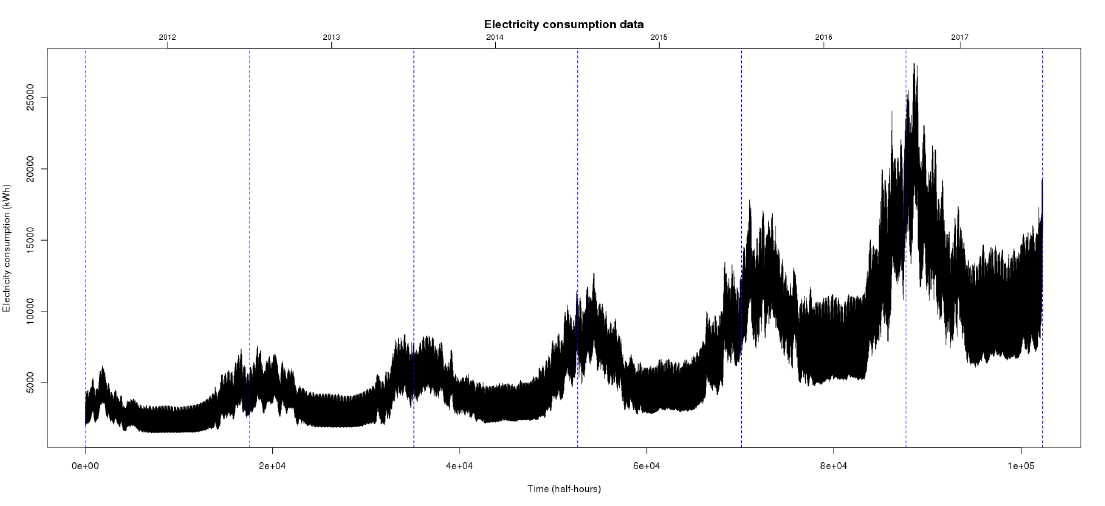
Figure 4. Electricity demand for the supplier Enercoop for six